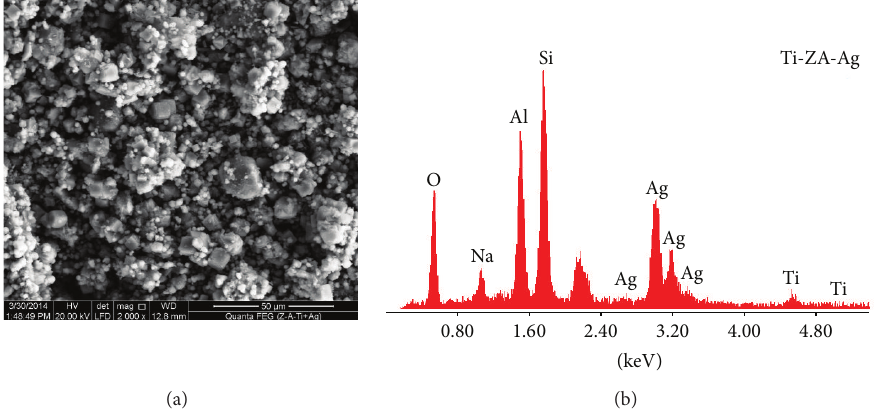
Figure 5: SEM and EDS chemical analysis for the Ag-substituted